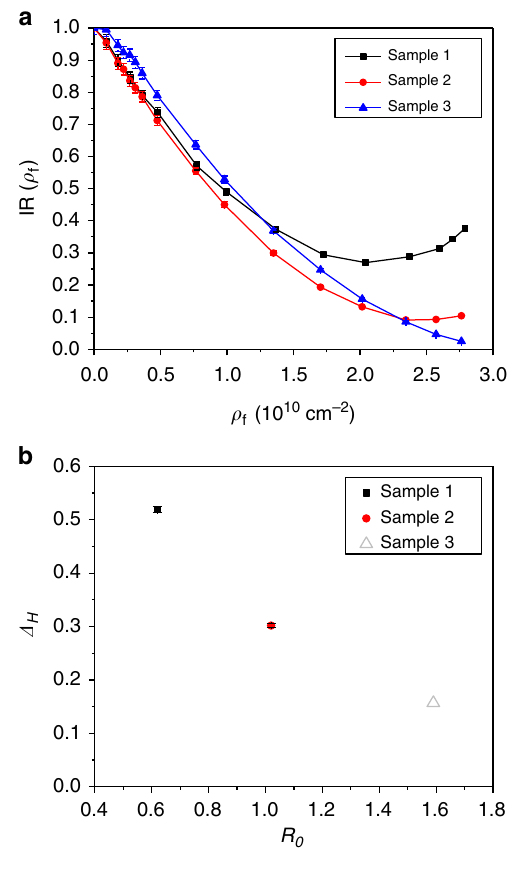
Fig. 4 Analysis of shale kerogens using generalized Porod ’ s scattering law method. a Intensity ratio, IR( ρ f ) = I ( Q , ρ f )/ I ( Q , ρ f = 0), which is also the ratio of generalized Porod ’ s scattering constant C GPS ( ρ f )/ C GPS ( ρ f = 0), for Sample 1 (black squares, least mature kerogen), Sample 2 (red circles), and Sample 3 (blue triangles, most mature kerogen) as a function of ρ